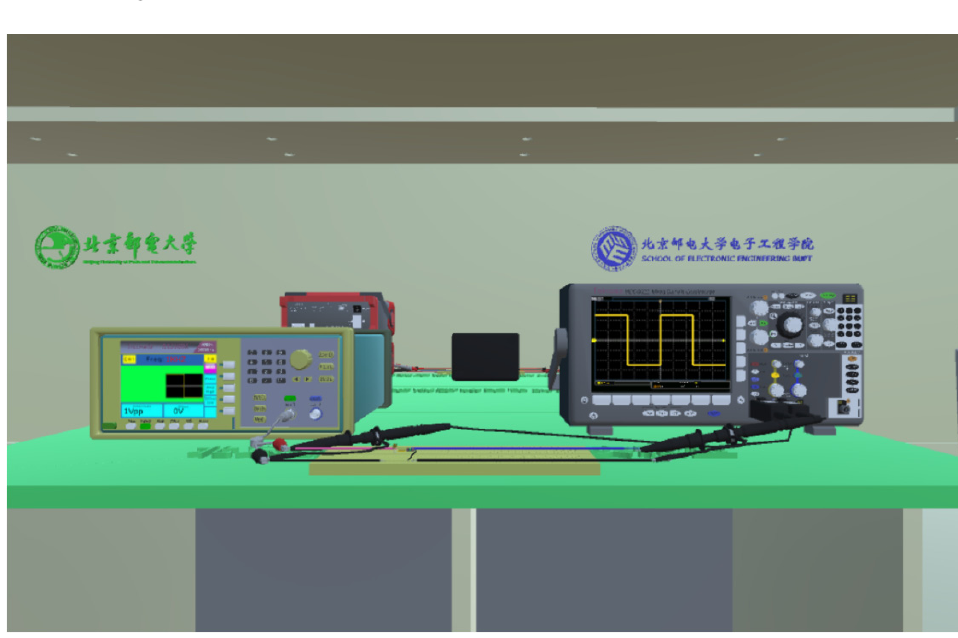
Figure 6. Electronic Circuit Laboratory. The non-English part is the emblem, name or the website title of